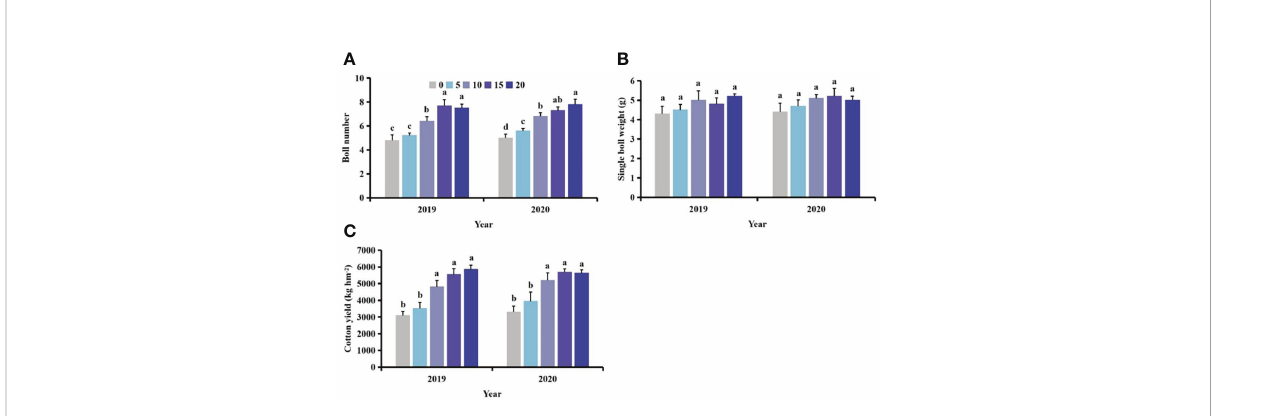
FIGURE 11 Effects of different spatial distributions of Scirpus planiculmis on cotton (A) boll number, (B) single boll weight and (C) cotton yield. The mean value ± standard data were presented in the fi gure. Different alphabetical letters indicate the signi fi cant differences between different distances ( p <0.05).